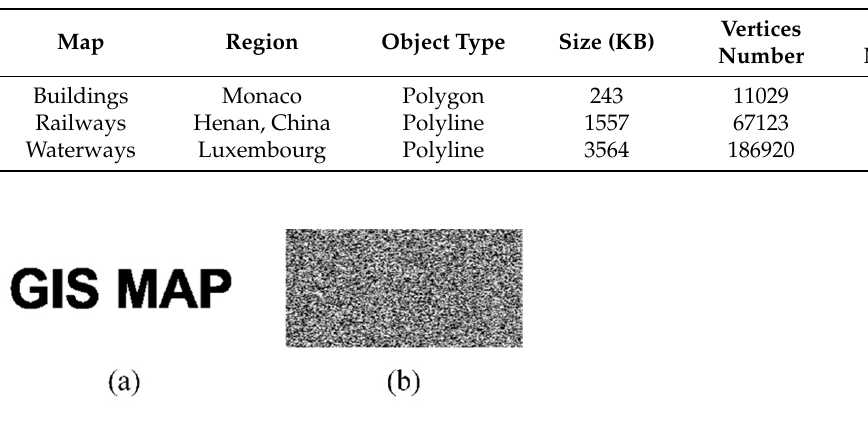
Figure 6. Watermark information: ( a ) original watermark, ( b ) shuffled watermark. Table 1. The detailed information of the GIS vector map